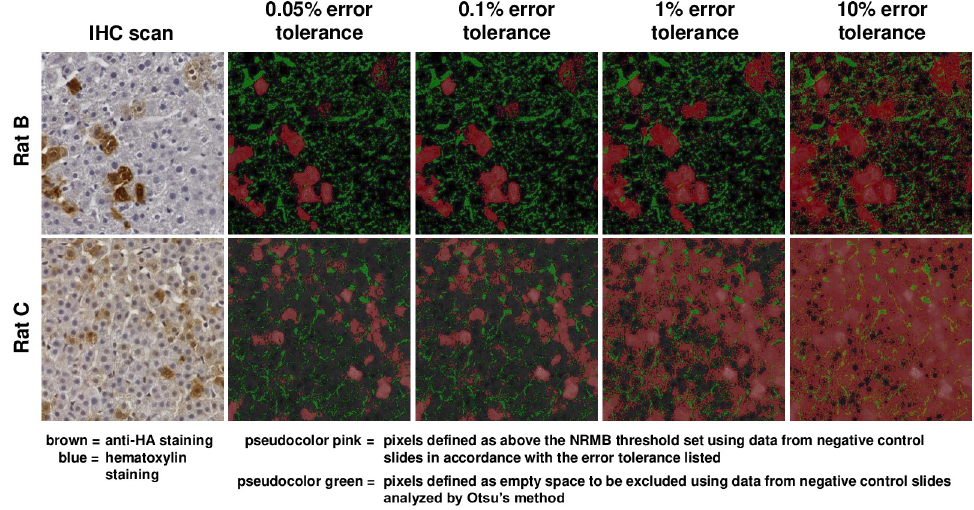
Fig 2. Visual representation of the impact of changing error tolerance limits on the definition of DAB-stained versus unstained tissue pixels in 2 test slides. Panels on the left are true color. All other panels present the same images in pseudocolor, with green representing pixels deemed empty space, pink representing pixels deemed DAB-stained tissue, and dark gray representing pixels deemed unstained tissue.